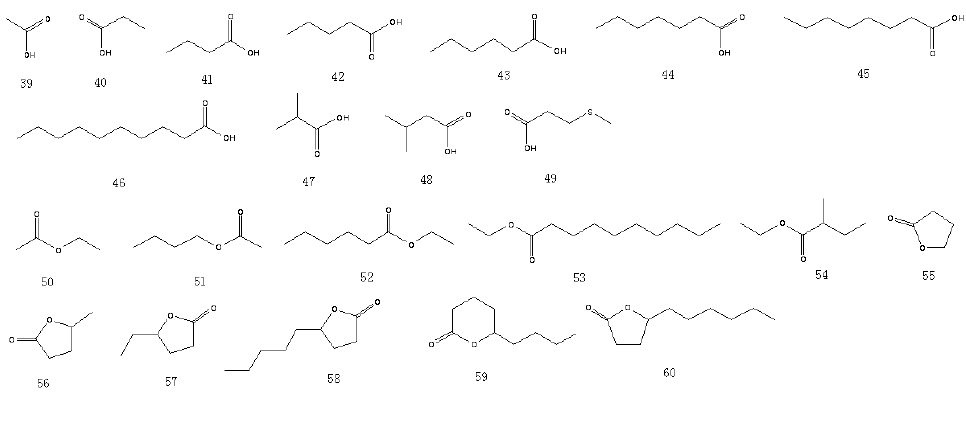
Figure 3. Structures of the acids, esters and lactones in Jinhua